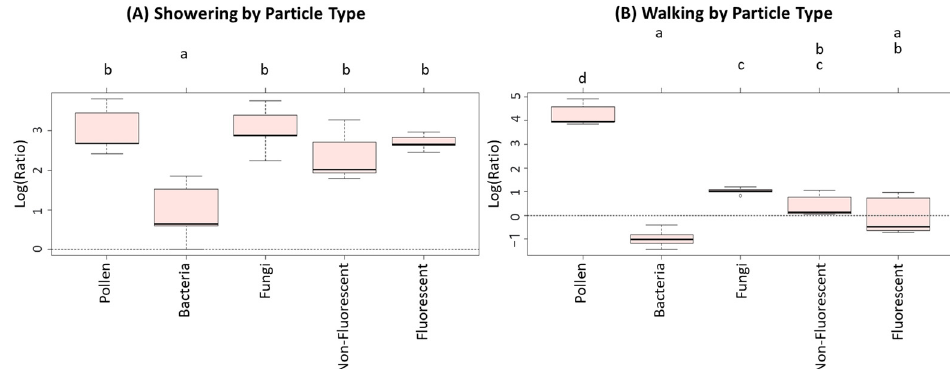
Figure 4. The Compact Letter Display (CLD) graphs portraying pairwise differences between showering and walking by each particle type. Log-transformed concentration ratios were used to check on pairwise differences among the type of particles for showering and walking ( A = Showering and B = Walking) by applying Tukey’s HSD method, whose results were summarized by the CLD graphs. In each CLD graph, the five-point summary was portrayed as a box plot (minimum, first quartile, median, third quartile, maximum) of five data points for each particle type within the activity. The dotted line in each CLD graph was drawn at log-ratio zero or, equivalently, ratio one. Any two treatments receiving the same letter at the top of the graphs are not significantly different as per Tukey’s HSD method.